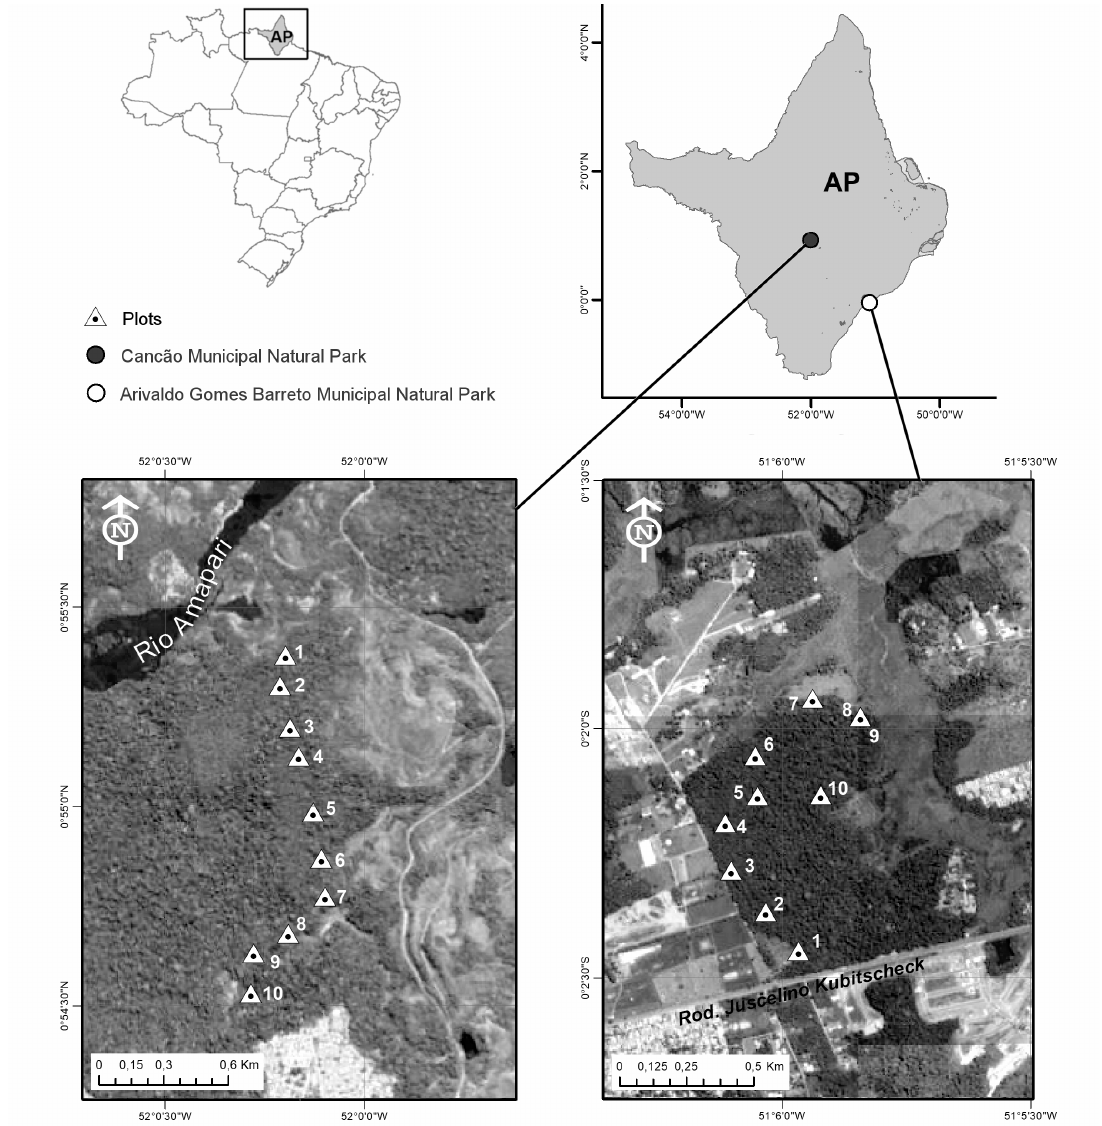
Figure 1. Localization map of the two Municipal Natural Parks, Amapá state, Brazil. Source: Spatial Analysis Laboratory (UAS), Museu Paraense Emilio Goeldi